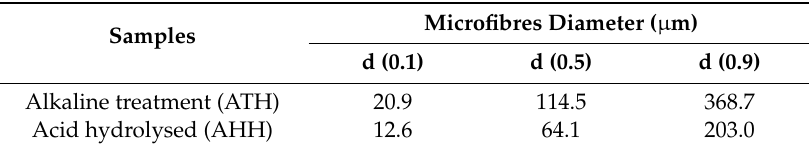
Table 1. Particle size measurement of ATH and AHH microfibres.